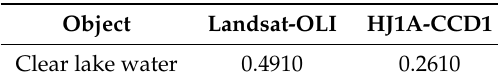
Table 10. The PSI of natural